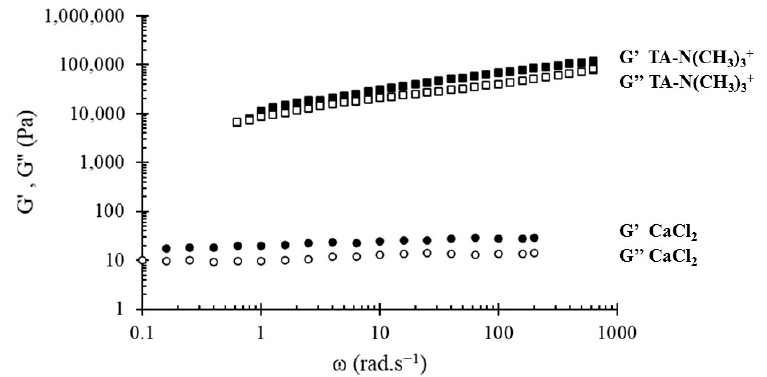
Figure 7. Frequency dependences of the storage modulus G’ and loss modulus G” of PHOSO 3 − at 96 g·L − 1 with CaCl 2 and TA-N(CH 3 ) 3 + .